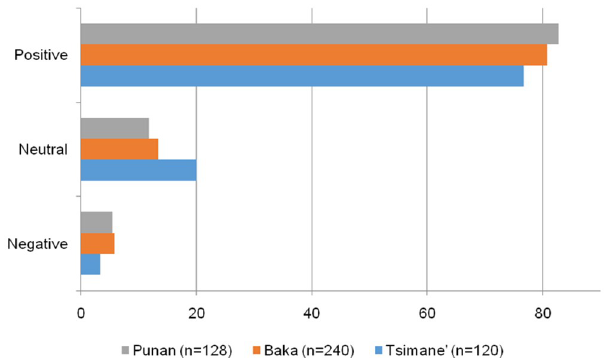
Fig 4. Distribution of unexplained observations (n = 488), by life satisfaction categories and society.